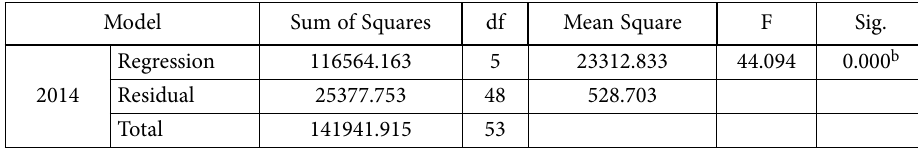
Table 2. ANOVA test afferent to the model for 2014 Model Sum of Squares df